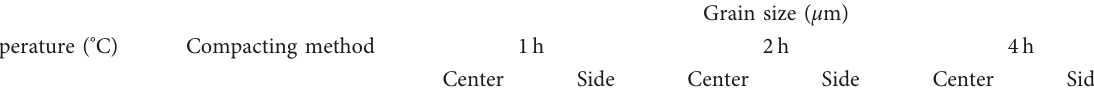
Table 2: Comparison of the grain sizes of the central and outer regions in the sintered specimens prepared using the three compacting methods (uniaxial pressing, CIP, and MPC).